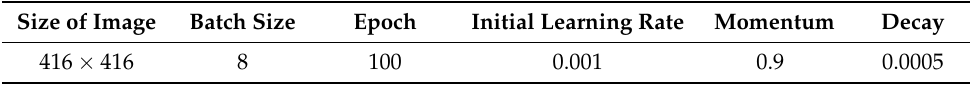
Table 5. YOLO-SC model initialization parameters.